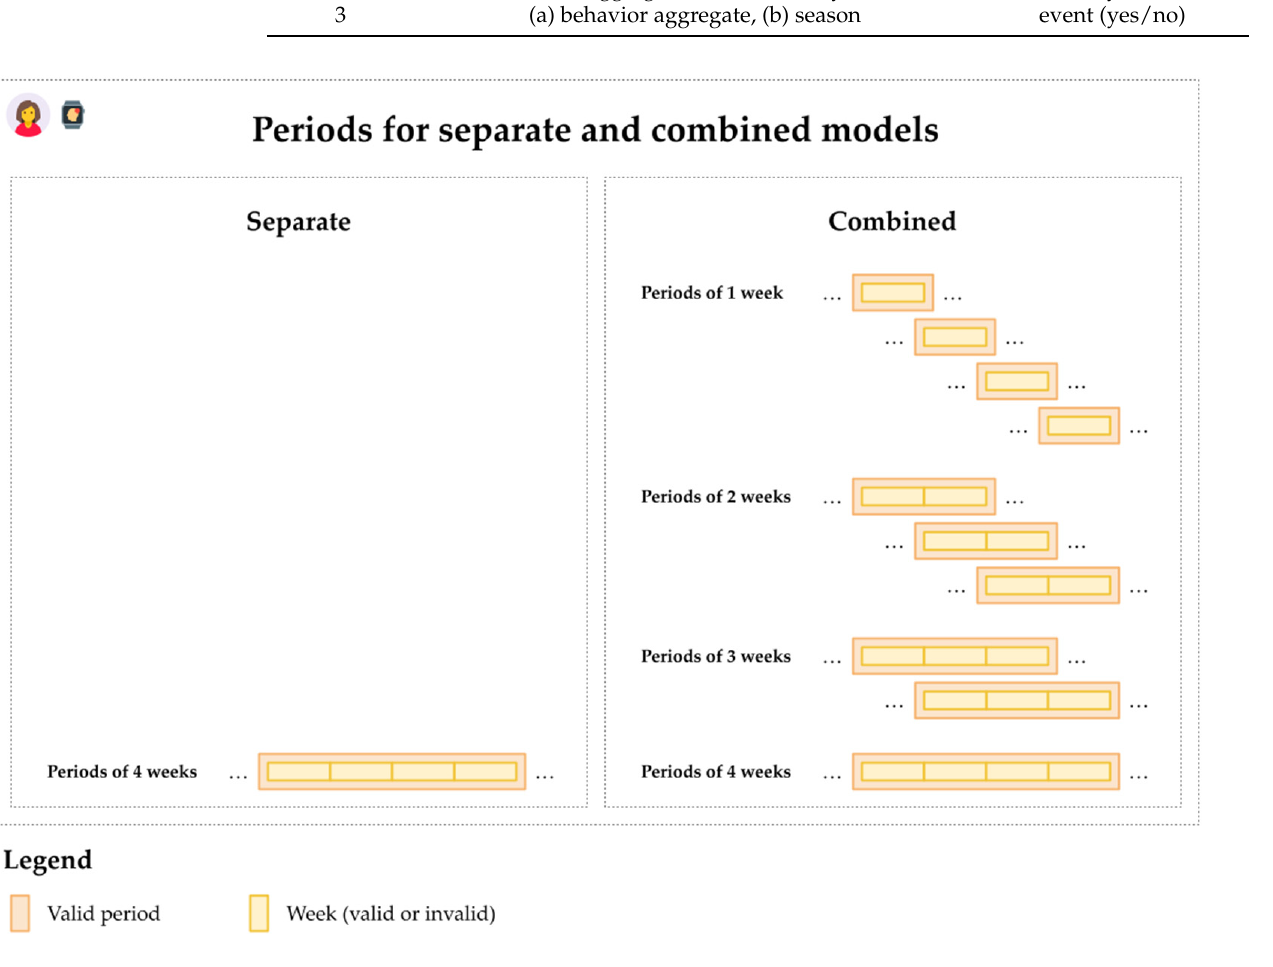
Figure 4. Periods in separate and combined models for a fixed duration of four weeks. Periods (depicted in orange) span across 1–8 weeks (depicted in yellow). For the separate models, only periods of precisely four weeks are included. For the combined models, periods of up to 4 weeks (precisely one week, and precisely two weeks, and precisely three weeks, and exactly four weeks) are